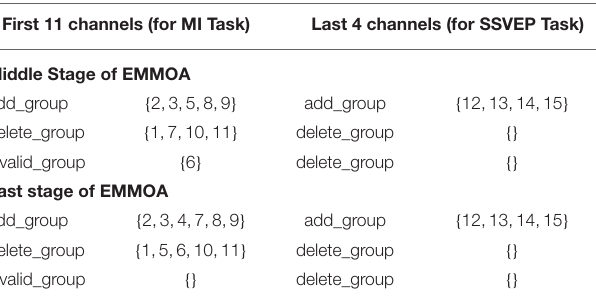
TABLE 6 | Results outputted by decision variable analysis operator. First 11 channels (for MI